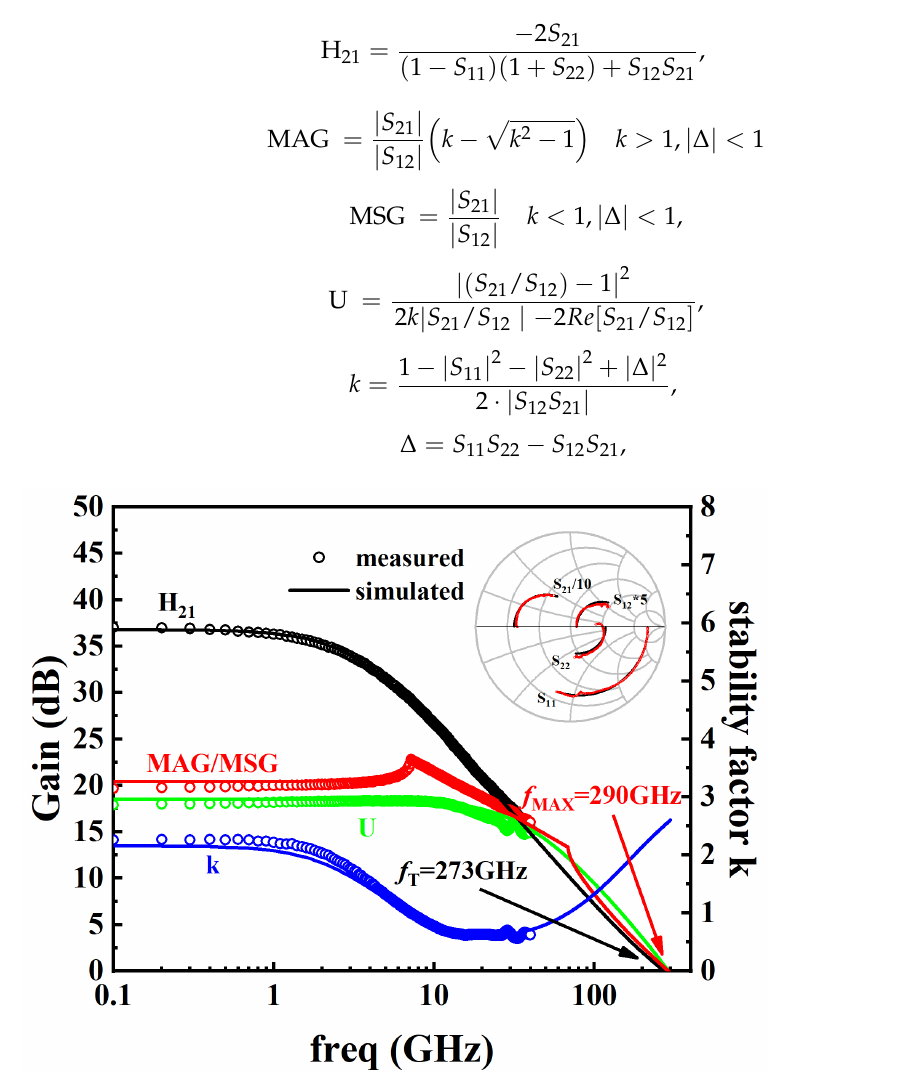
Figure 8. RF characteristics of the HEMTs at V G = − 0.4 V and V D = 0.8 V. In addition, the small-signal model of HEMTs fabricated on Si substrates was made at the g m , max point of V G = − 0.4 V and V D = 0.8 V. The device modeling parameters are tweaked until the S-parameters matche closely with the measured parameters, as shown in Figure 8. Since the limitation of test frequency, f T and maximum oscillation frequency (f MAX ), were obtained by extrapolating the simulated curve of H 21 and MAG/MSG. The extrapolated f T and f MAX were 273 and 290 GHz, respectively. The f T and f MAX are expressed by Equations (7) and (8).